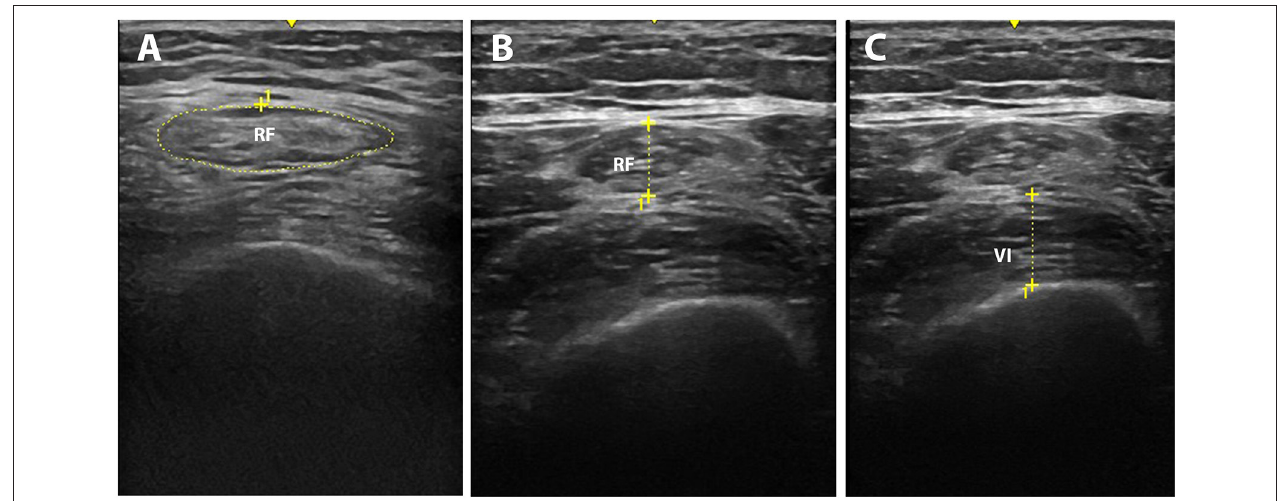
FIGURE 1 | Representative muscle ultrasound image methods: rectus femoris cross-section area (A) , the thickness of the anterior compartment of the quadriceps muscle [rectus femoris (B) and vastus intermedius (C) ].